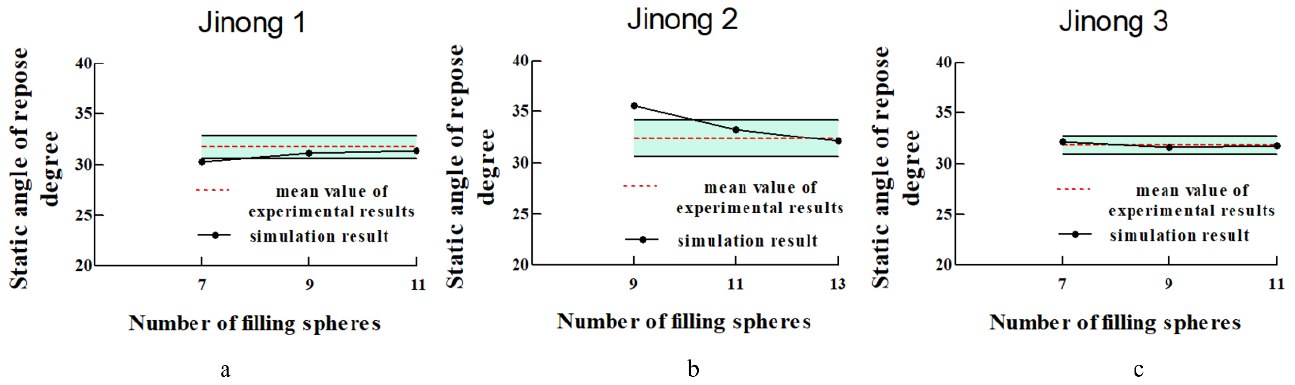
Figure 22. ( a – c ) Variations of the simulated static angle of repose versus the number of filing spheres for different varieties of seeds.